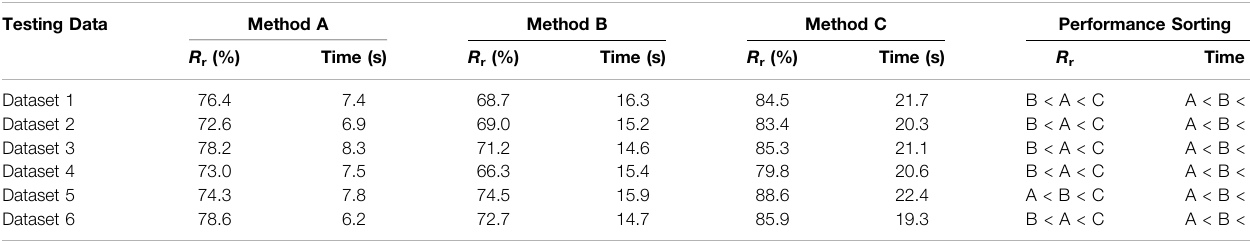
TABLE 3 | Detection Performance Comparison between the Three Methods in case 1. Testing